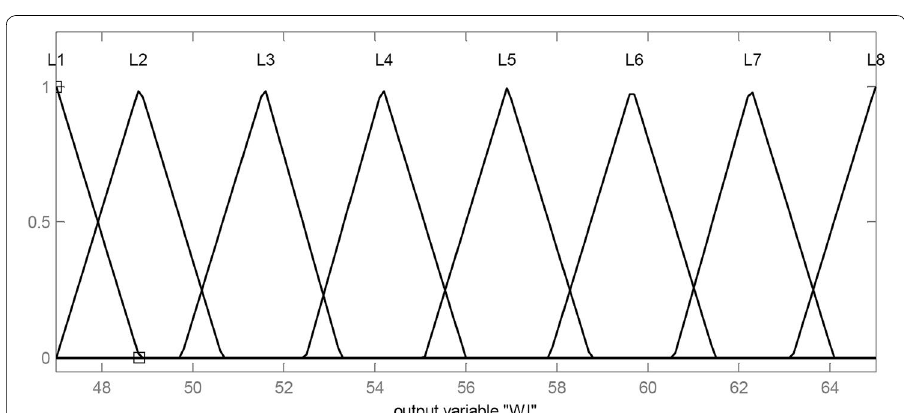
Fig. 5 Membership function of input variable “ WI